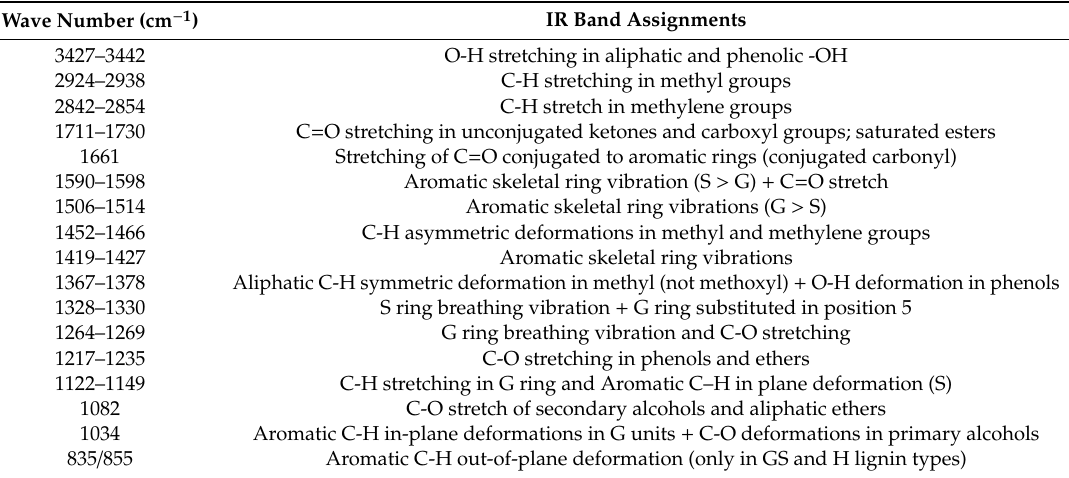
Table 2. IR band assignments